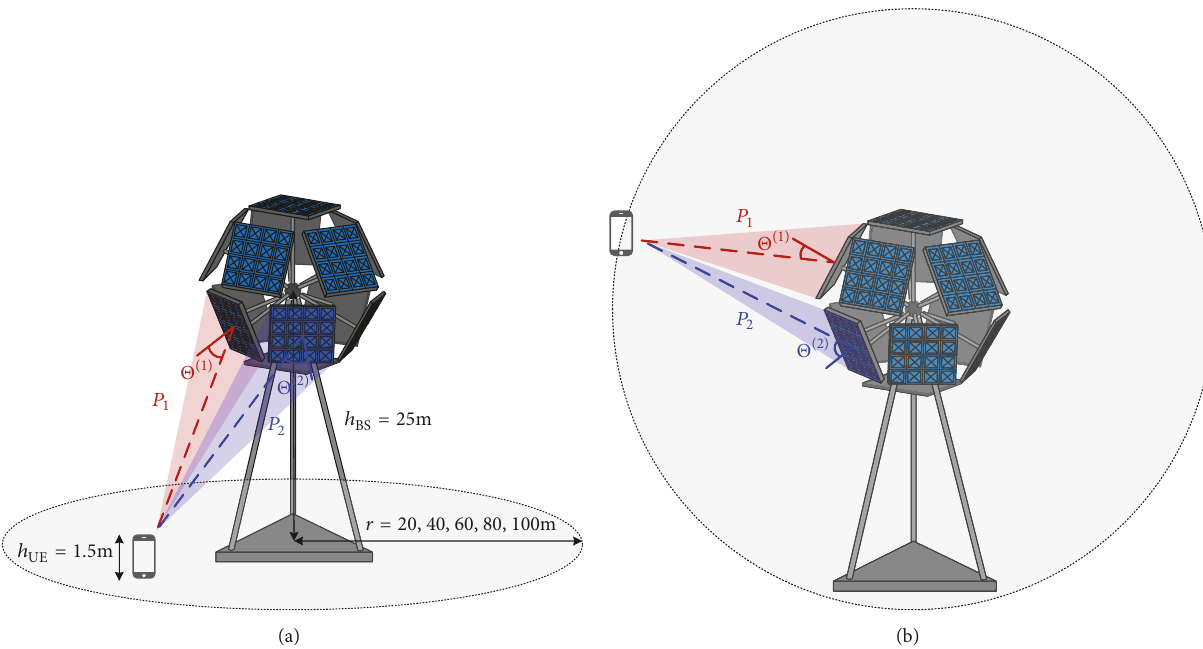
Figure 6: : Performance evaluation models: (a) 2D UE distribution and (b) 3D UE distribution.